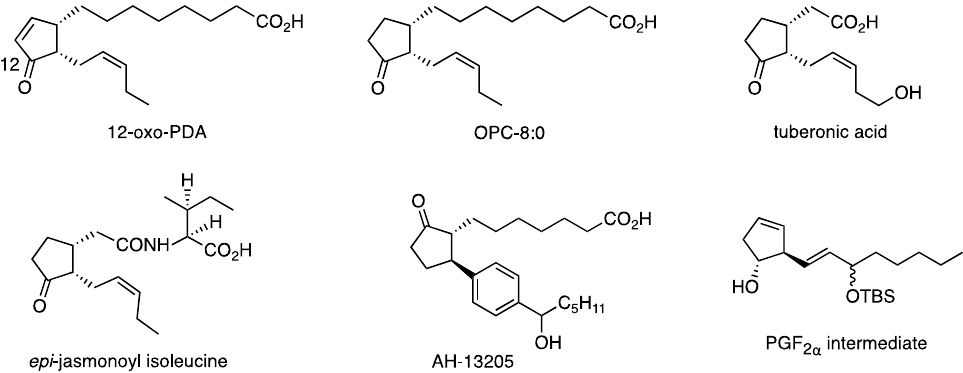
Figure 6. Cyclopentanoids synthesized by using RMgX/CuCN.